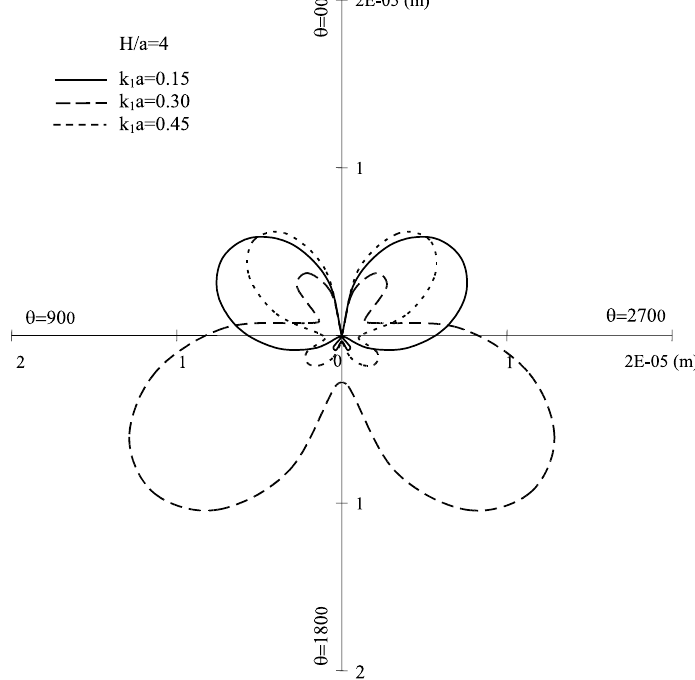
Fig. 3. Variation of the circumferential displacement ( u θ ) with θ at r = a for various values of wave number k 1 a .